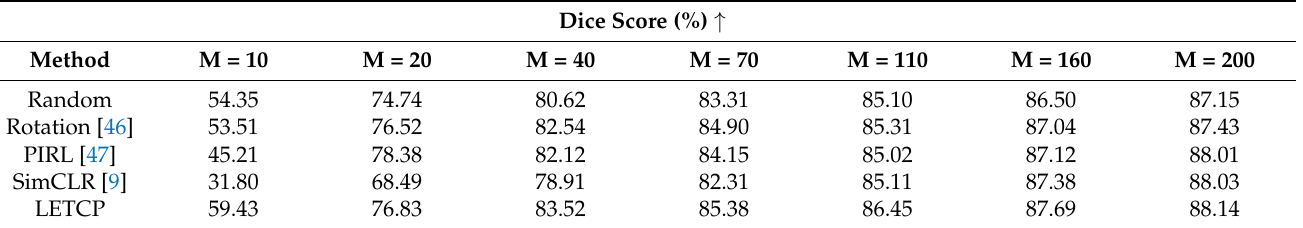
Table 1. Comparison of the proposed LETCP method with other baselines on BraTS 2021 [1–3]. ↑ means higher is better.